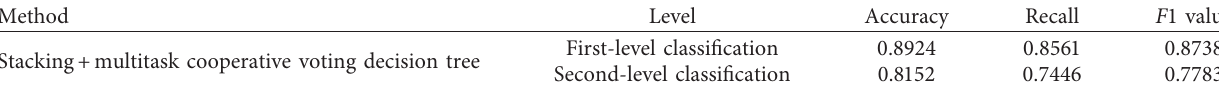
Table 6: Multilevel classification results of multitask cooperative